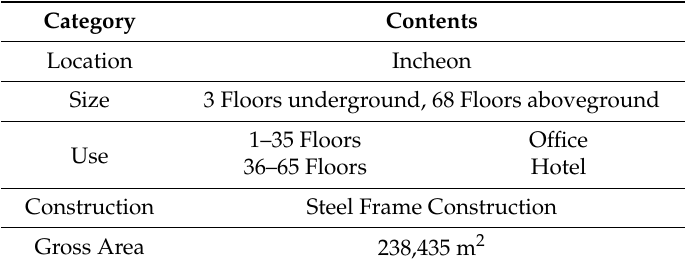
Table 1. Overview of target building.